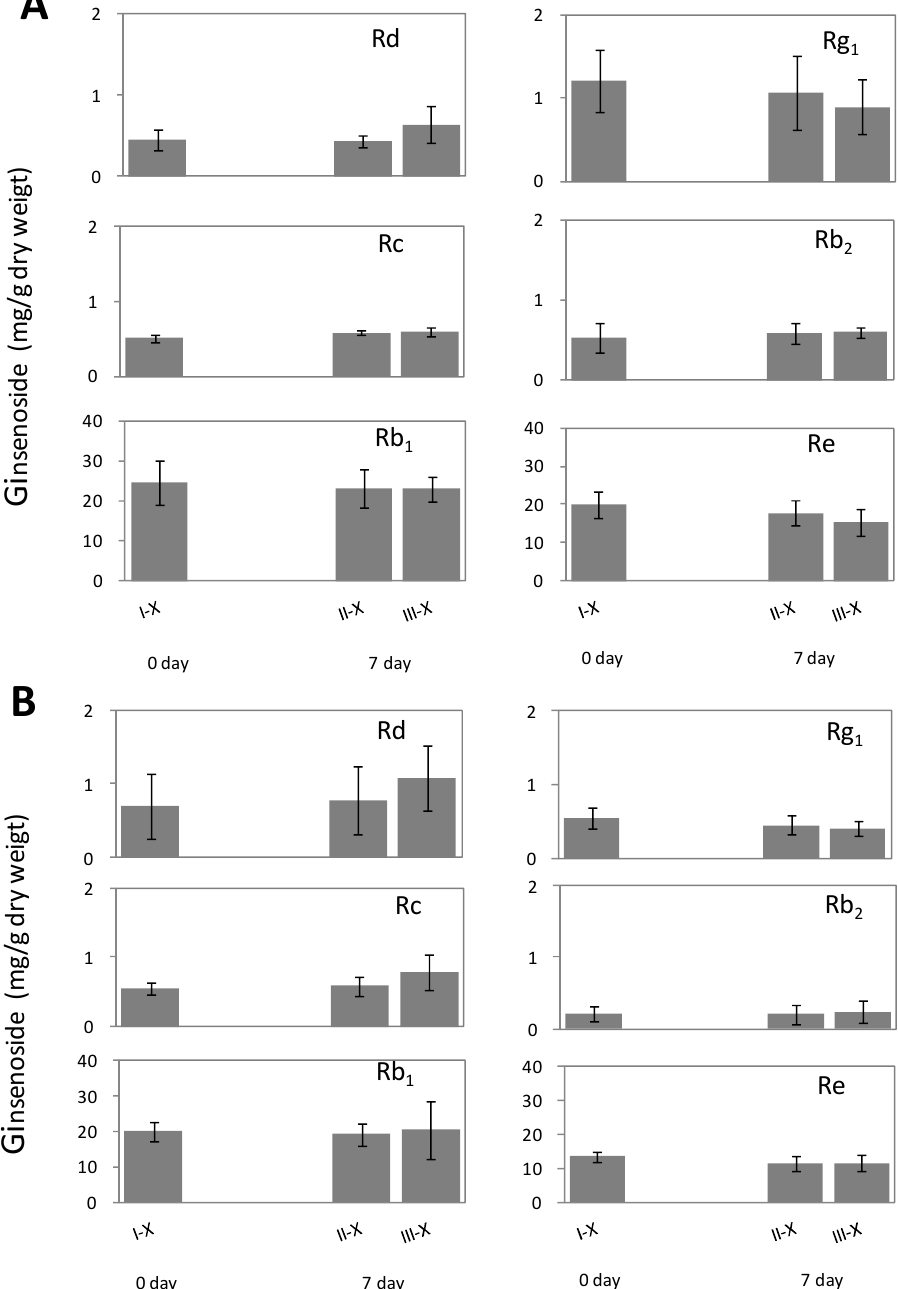
Figure 5. Measurements of ginsenoside Rg American ginseng roots after inoculation for 0 or 7 days with: ( A ) Fusarium solani and ( B ) F. oxysporum . Root treatments include untreated (I-X), PDA plug (II-X), and Fusarium culture (III-X). Bars of mean values of ginsenoside with no letters indicate no